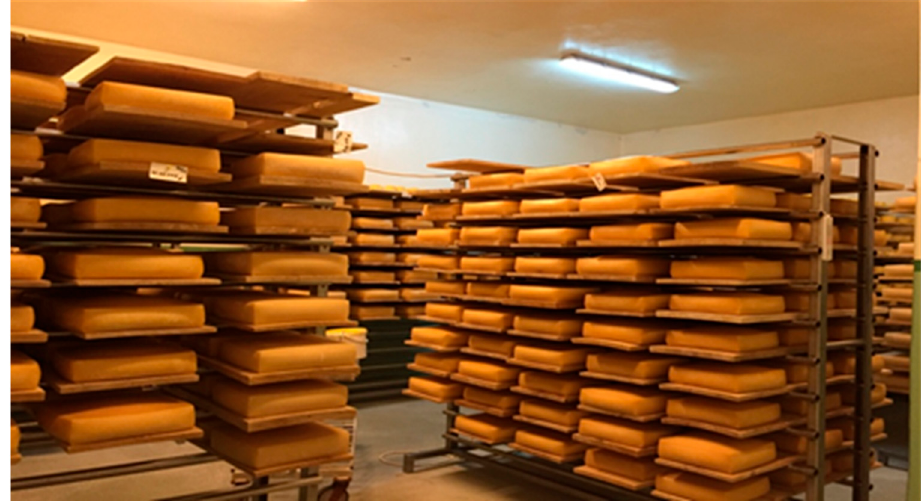
Figure 1. Apuseni cheese.